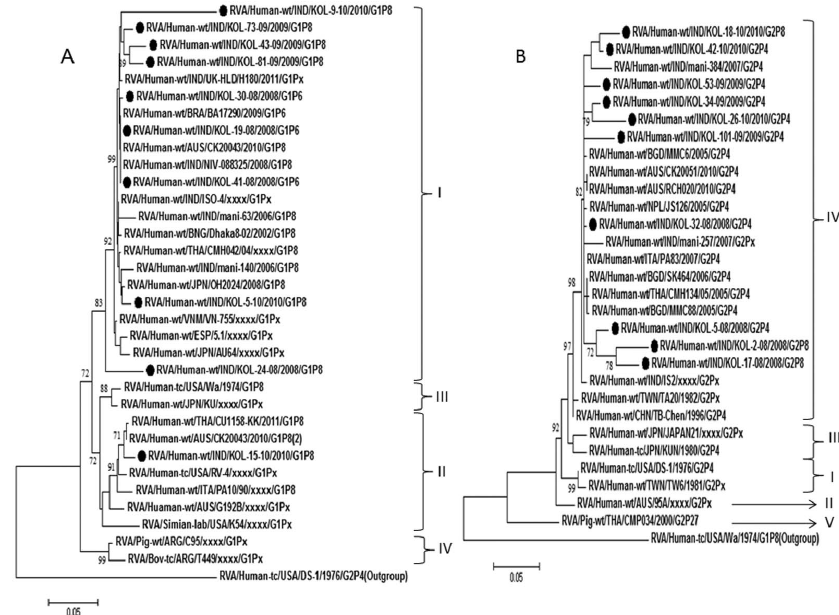
Figure 3. A and B. Phylogenetic trees of the G1 and G2 strains of Kolkata. Phylogenetic trees constructed from the nucleotide sequences of VP7 genes of A. G1; B. G2 strains of Kolkata, isolated during January 2008 through December 2010, with other representative G1 and G2 strains respectively. A. One Kolkata G1 strain showed its relatedness to lineage II G1 strains and the rest G1 strains clustered with lineage I G1 strains. B. All Kolkata G2 strains clustered with lineage IV G2 strains. Scale bar, 0.05 substitutions per nucleotide. Bootstrap values less than 70% are not shown.